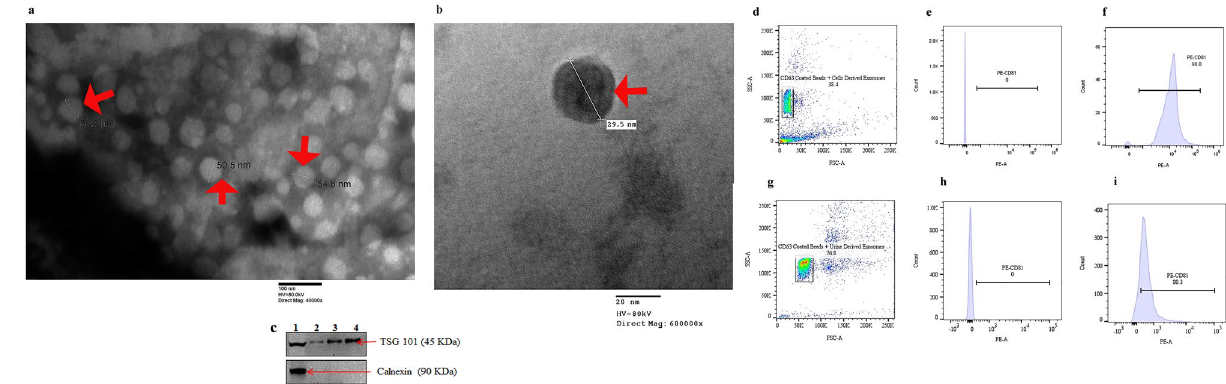
Figure 1. Characterization of exosomes. Electron microscopy of ( a ) HK-2 cells-derived exosomes. ( b ) Human urinary exosomes. The exosomes are shown by the red arrows. ( c ) Western blot of classical exosomal marker TSG 101 (exposure time: 120 s) and non-exosomal marker Calnexin (exposure time: 30 s); 1: HK-2 cells; 2,3: 2 and 3 mg of protein of healthy volunteer normalized to urine creatinine; 4: 30 μg of protein from HK-2 cells-derived exosomes. The original blots are presented in Supplemental Fig. S2. Scatter plot analysis of CD63 coated beads with ( d ) HK-2 cells-derived exosomes and ( g ) Human urine-derived exosomes. Gating of antibody bead conjugated exosomes derived from ( e ) HK-2 cells ( h ) human urine. The antibody bead exosome complex stained with anti-CD81 PE exhibited ( f ) 98% of positive CD81 vesicles derived from HK-2 cells. ( i ) Exosomes derived from human urine showed 80.3% of positive exosomes. TSG, Tumour Susceptibility Gene; SSC, Side Scatter; FSC, Forward Scatter; PE,